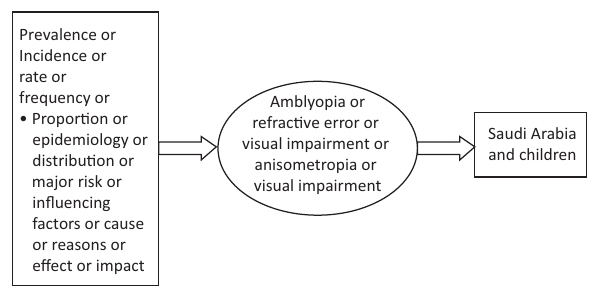
FIGURE 1: Example of Boolean operators used in the search strategy for the current